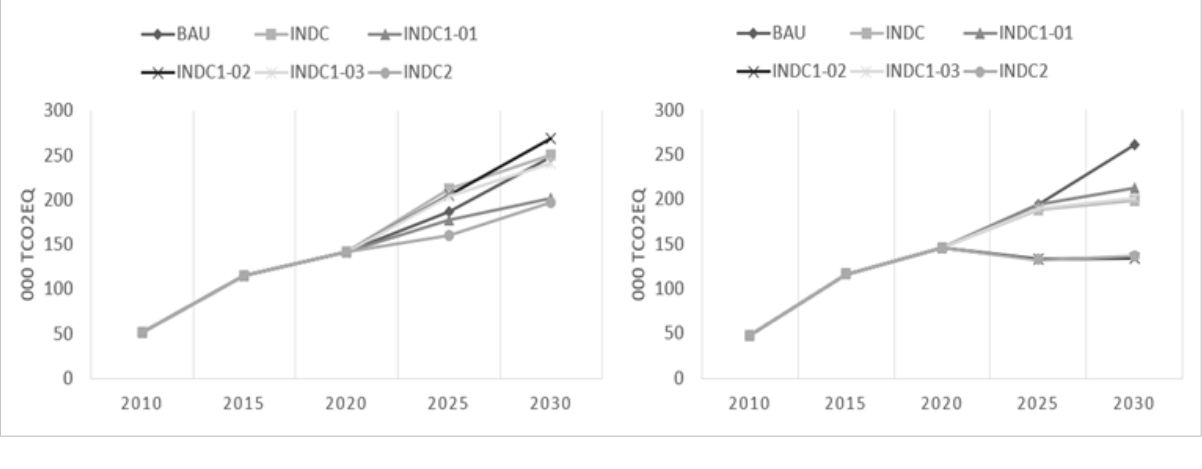
emission in each 2